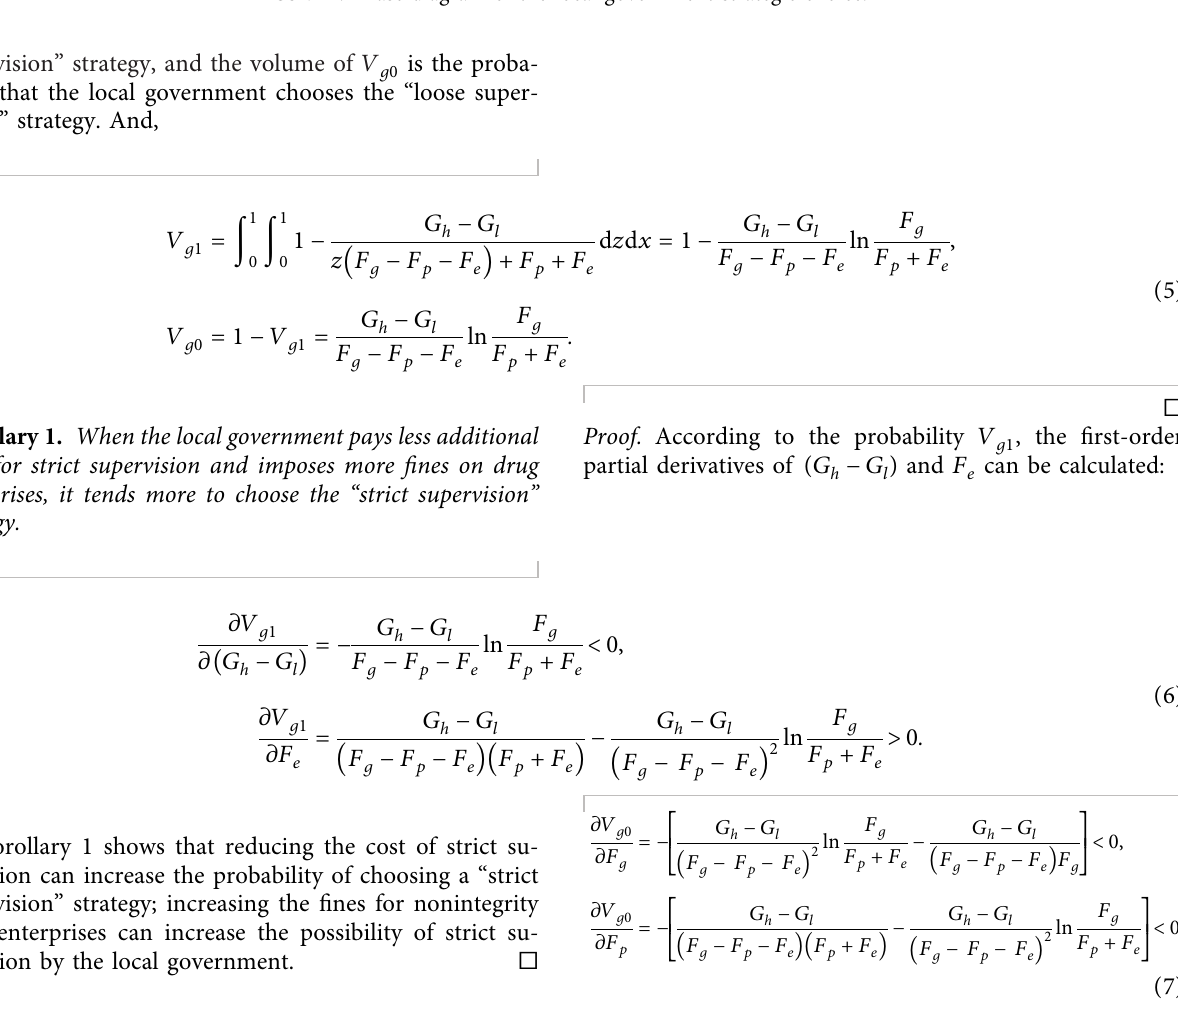
Figure 2: Phase diagram of the local government strategic